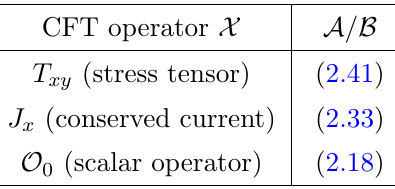
= in the asymptotic A B